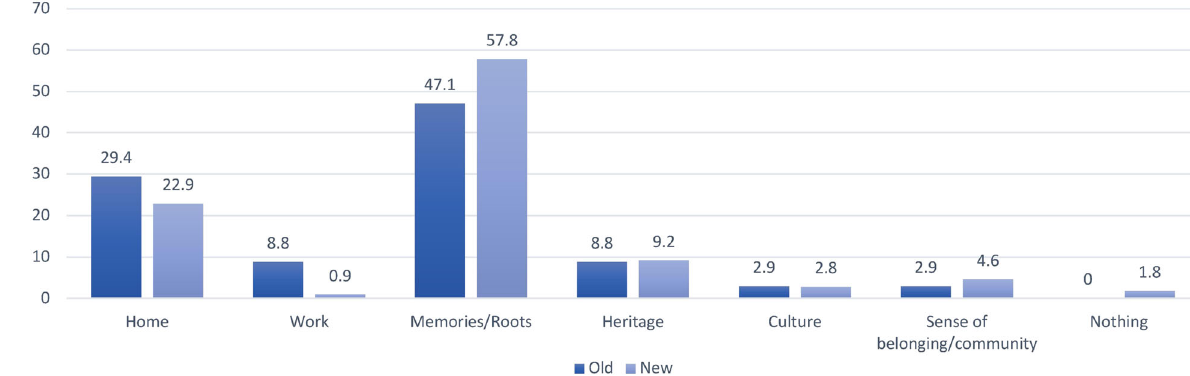
Fig. 1 Local community. Most important losses due to the forced removal.